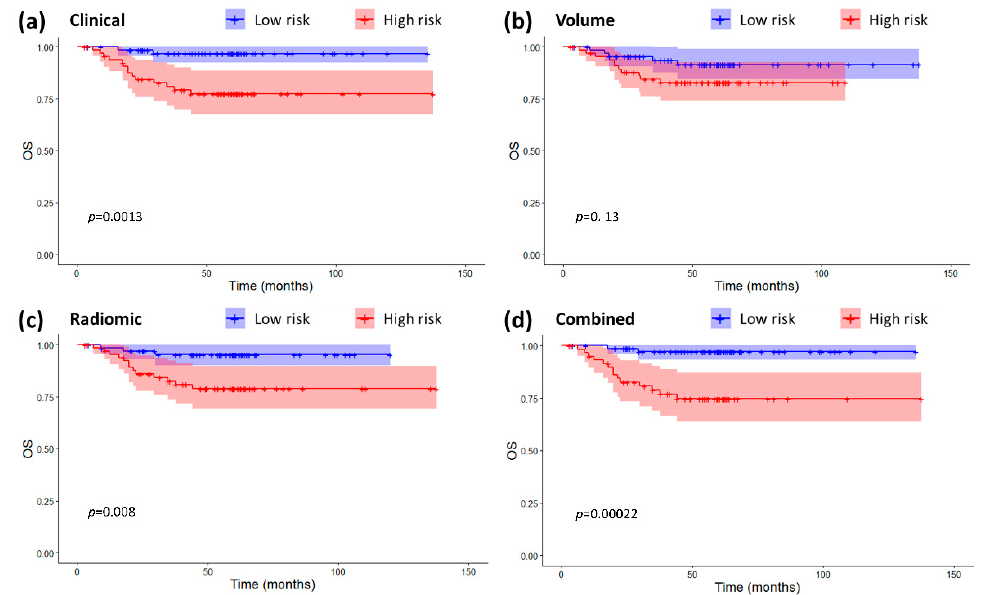
Figure 1. Kaplan-Meier curves and confidence intervals for overall survival (OS) in the high and low risk groups as defined by the four prognostic models. ( a ) Clinical model. ( b ) Volume-based model. ( c ) Radiomic model. ( d ) Combined radiomic-clinical model. The p -values for the log-rank tests are also displayed on the plots. Crosses represent censored data.